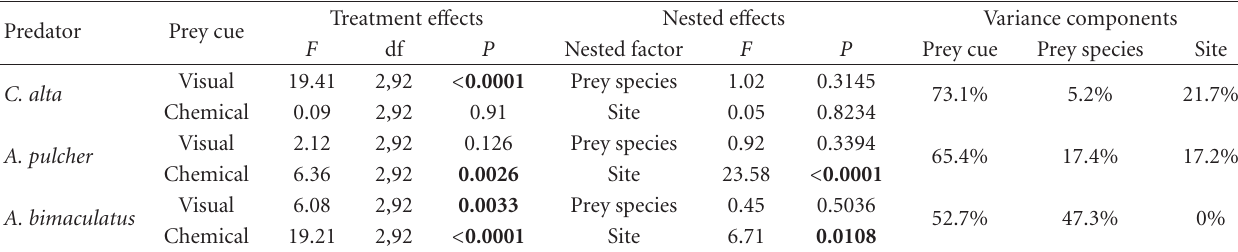
Table 1: E ff ects of di ff erent combinations of cues from two prey species indicating potential foraging opportunities on the local abundance of three predatory species in a nested ANOVA with observation site nested within prey species ∗ .